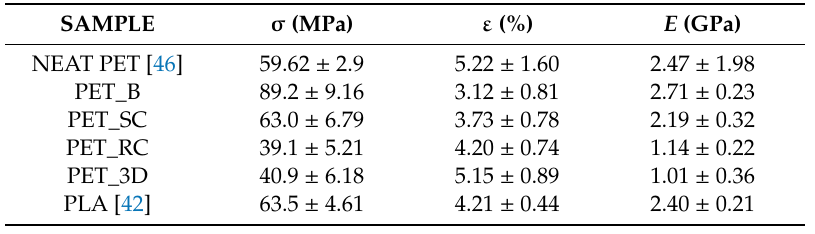
Table 4. Mechanical properties of PET samples.